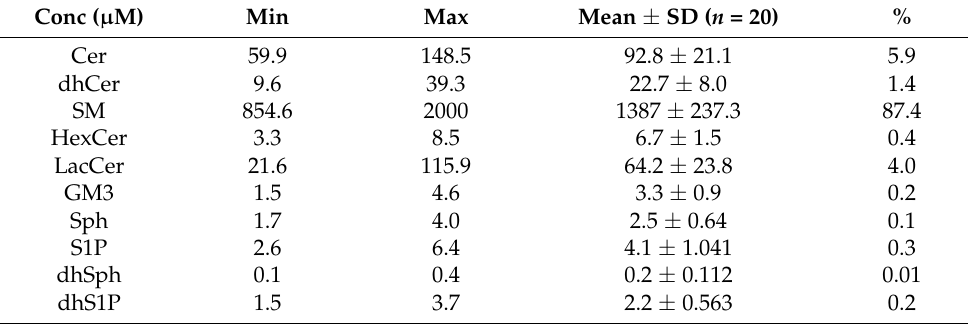
Table 4. RBCs sphingolipid levels ( µ M) in healthy volunteers ( n = 20) expressed as min–max, mean ± SD and percentage over total sphingolipid